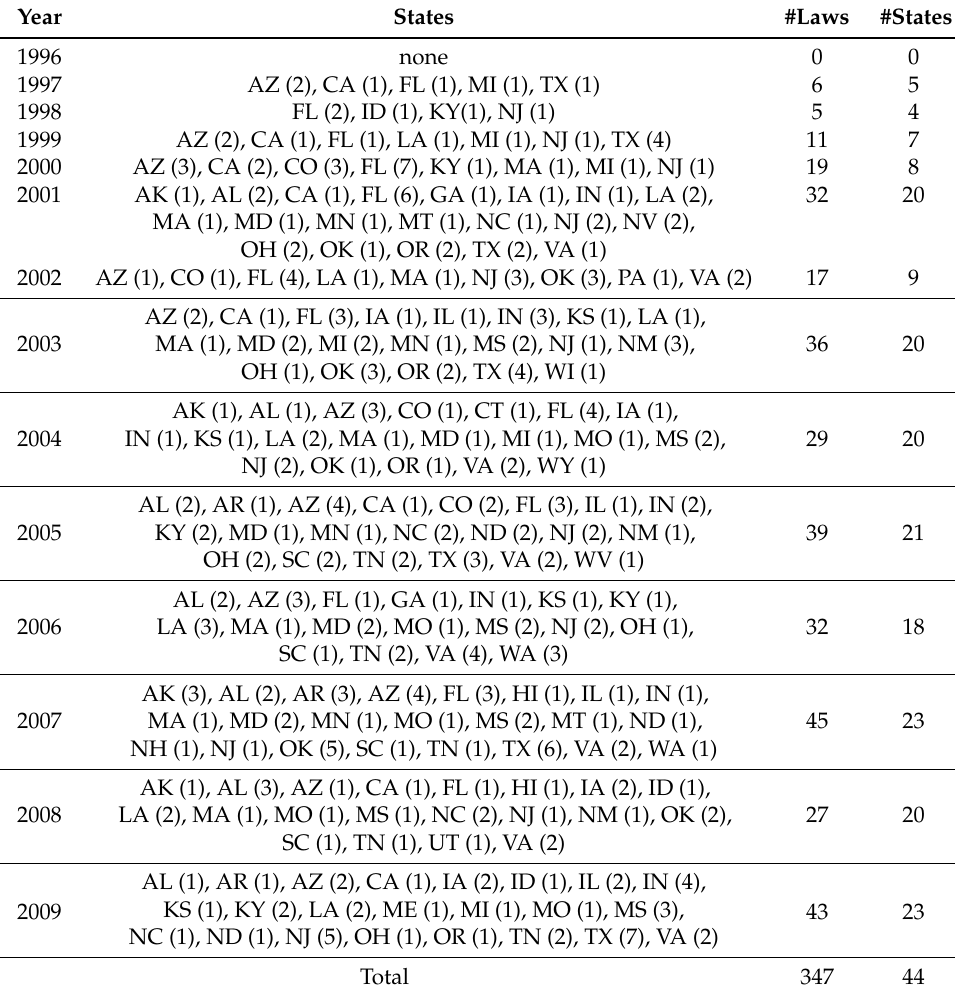
Table 2. State legislation by year. Number of faith-based laws passed by Year